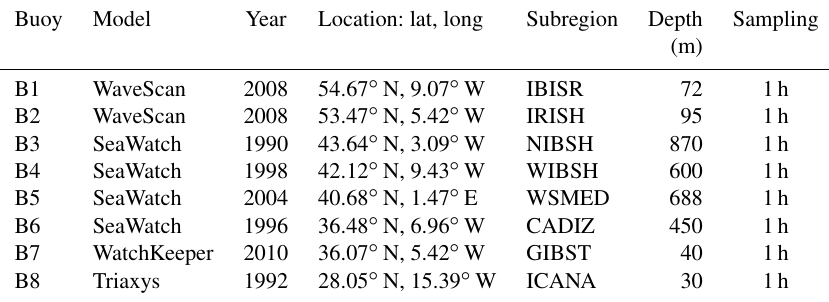
Table 2. Description of the network of directional buoys used in this work. Year label stands for year of deployment. Subregions are defined in Fig. 1a. Buoy Model Location: lat,